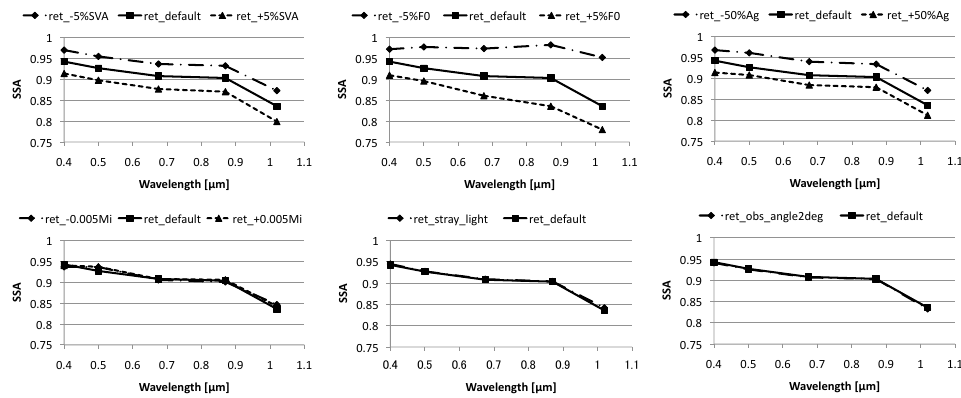
Fig. 2. SSA values in the sensitivity experiments as a function of wavelength at 0.400, 0.500, 0.675, 0.870, and 1.02µm. (cid:7) and N indicate the results with an error or with a change to the parameter applied as described in the graph legends. (cid:4) shows the result without error or change applied to the parameters. The following errors and changes were applied: ± 5% to F 0 , ± 5% to SVA, ± 50% to A g , ± 0.005 to the initial value of the imaginary part of the refractive index, an increase in the diffused intensity at scattering angle 3 ◦ by 5% at each wavelength (stray light), and a decrease in the minimum observable scattering angle of the sky radiometer from 3 ◦ to 2 ◦ .